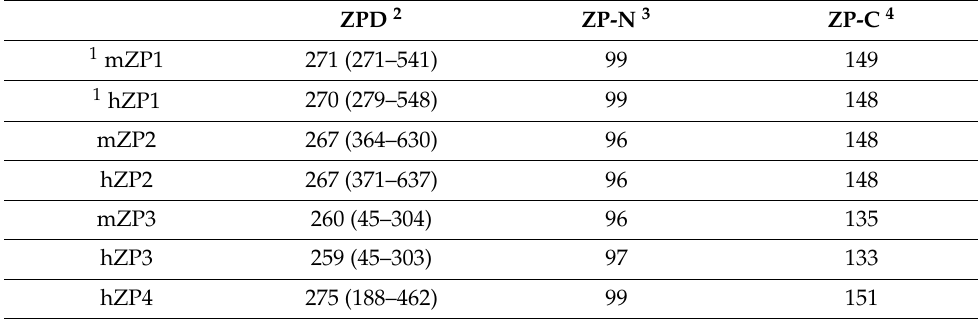
Table 1. The Zona Pellucida Domain of ZP1–4.